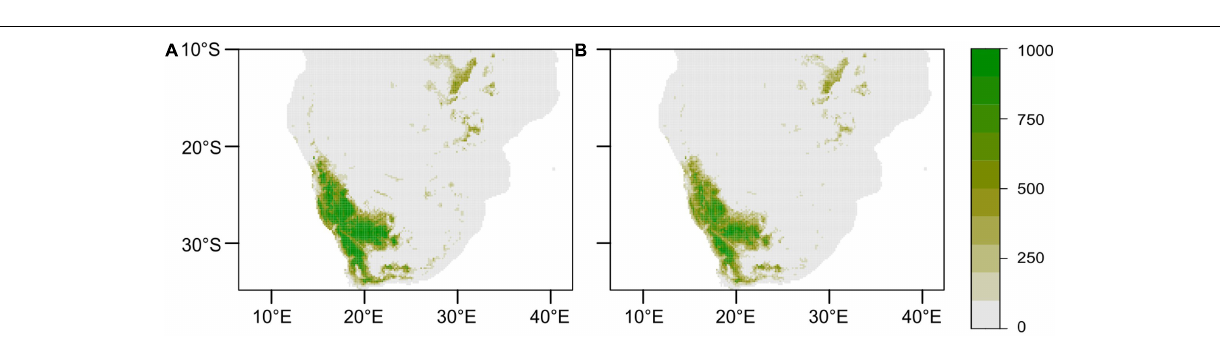
FIGURE 4 | The relative importance of the nine bioclimatic variables for each model algorithm used to model the current distribution of Aloidendron dichotomum . The four algorithms used include the generalised linear model (GLM), generalised additive model (GAM), generalised booted model (GBM), and random forest (RF).